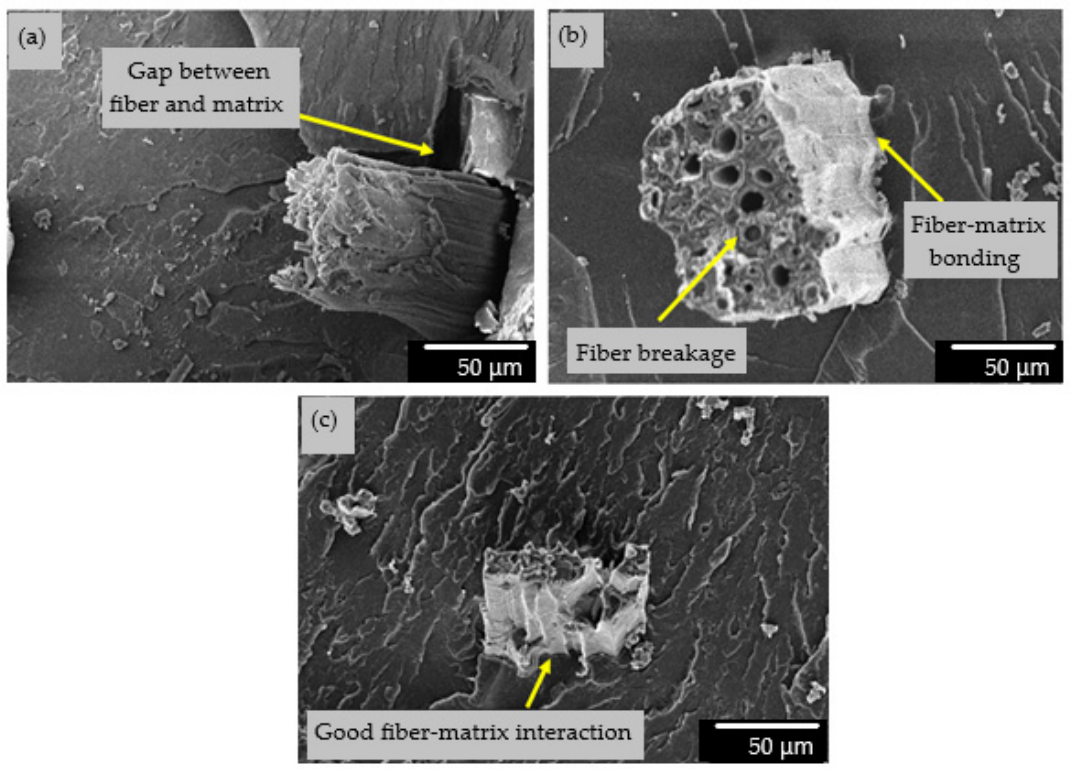
Figure 9. SEM micrographs KBF (20 wt %)-reinforced UPE composites tensile fracture surfaces at ×500 magnification. ( a ) Untreated KFB ( b ) KBF-treated 60 min MA ( c ) KBF-treated 90 min MA.